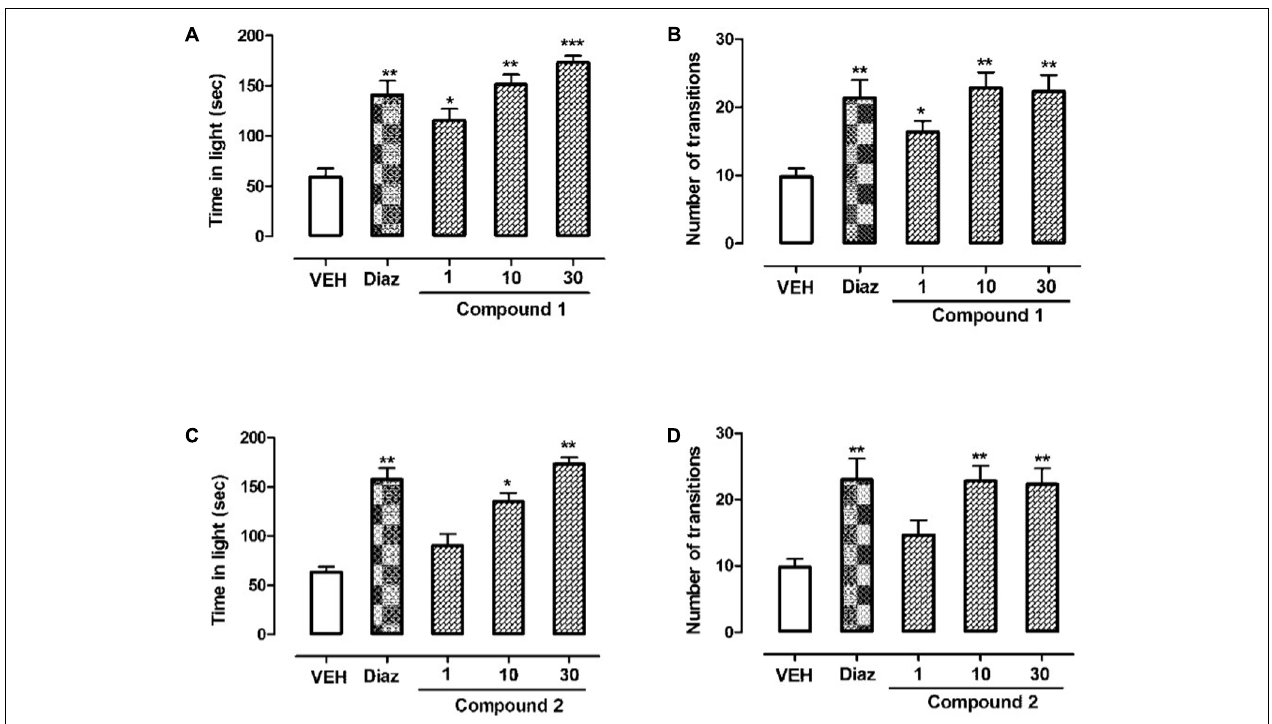
FIGURE 5 | Effect of compounds 1 and 2 and diazepam on the behavior of mice in the light–dark box test. (A) Time spent in lit area, (B) number of transitions recorded over a session of 5 min, after 20 min of an i.p. injection of compound 1 (1, 10, and 30 mg/kg), diazepam (1 mg/kg), or vehicle. (C) Time spent in lit area, (D) number of transitions recorded over a session of 5 min, after 20 min of an i.p. injection of compound 2 (1, 10, and 30 mg/kg), diazepam (1 mg/kg), or vehicle. Values express mean ± SEM ( n = 6/group). ∗ P < 0.05, ∗∗ P < 0.01, and ∗∗∗ P < 0.001 compared with vehicle group using one-way ANOVA followed by Dunnett’s test.